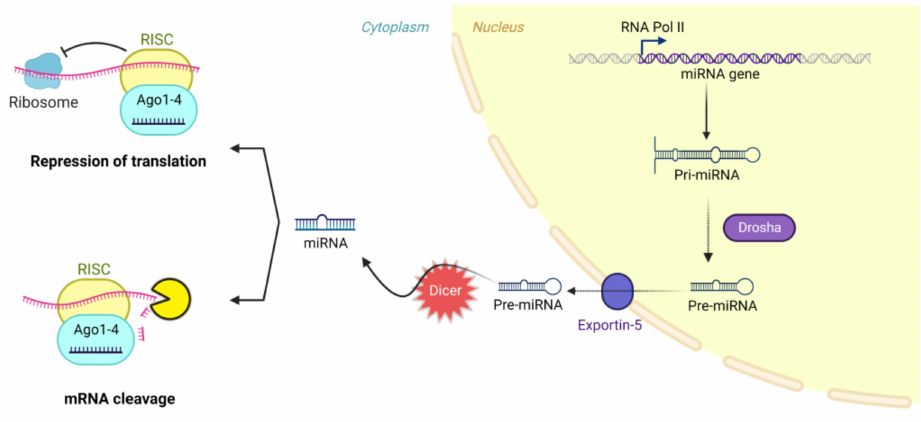
Figure 2. RNA interference mechanism by miRNA. Created with